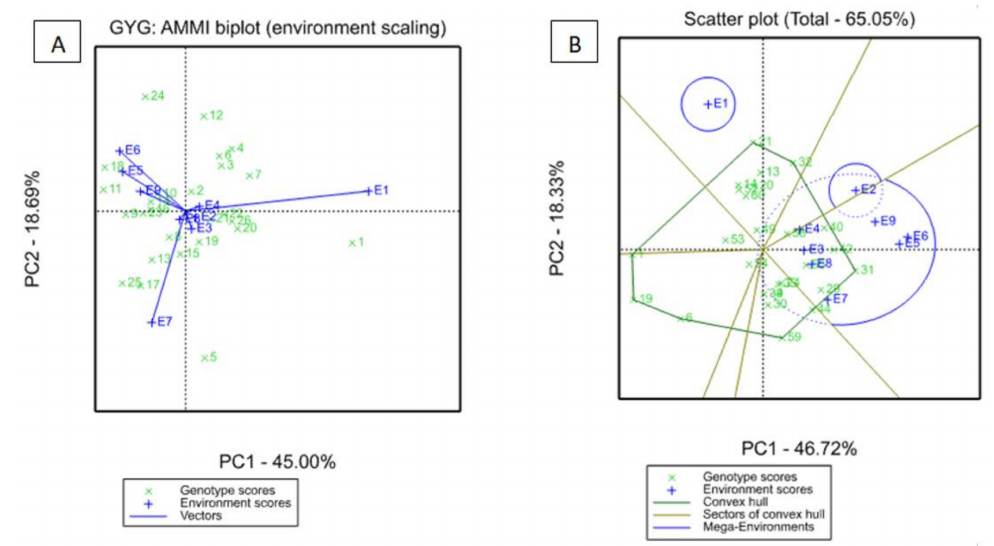
Figure 3. Biplots showing the positions of genotypes and environments on the scatter-gram. ( A ) A comparison AMMI scatter biplot for grain yield (environment scaling) showing the positions of the 26 genotypes and nine environments on the two dimensional scatter-gram, ( B ) A GGE biplot showing mega-environments depicted by grain yield scores of 26 maize genotypes evaluated across nine environments in Zimbabwe during 2019–2020 seasons. Genotypes are identified by a geno- type number (for Figure 3A) and a genotype code (for Figure 3B) prefixed by an ‘x’ all shown in Table 5. Environments are identified by a number prefixed by a ‘+E’, +E1 = Harare-DR&SS-2019; +E2 = Harare-CIMMYT-2019; +E3 = Gwebi-2019; +E4 = Chisumbanje-2019; +E5 = Panmure-2019;